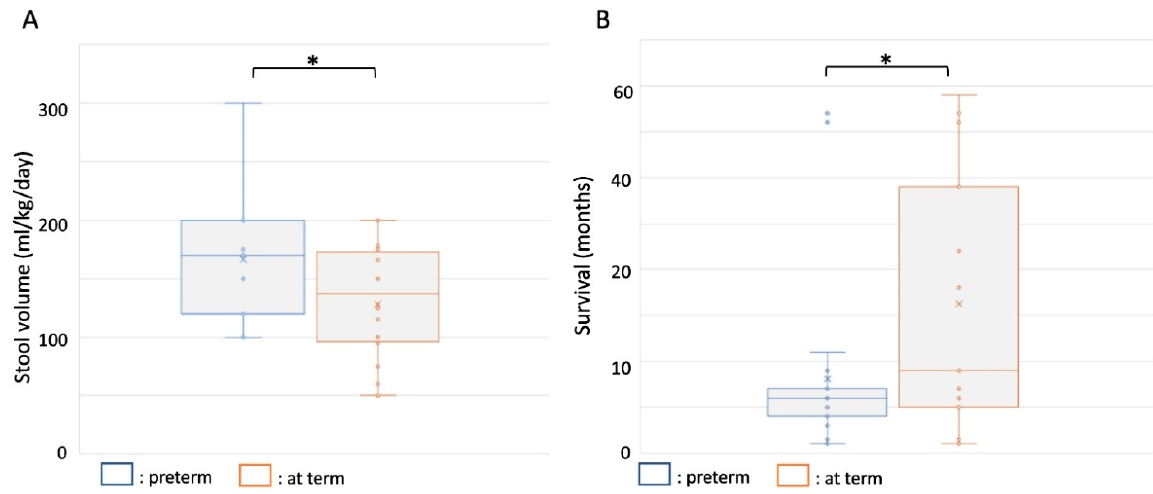
Figure 3. Stool volume and survival in MVID patients born preterm and at term. ( A ) Box-and-whisker plot showing average and mean stool volumes in MVID patients born preterm (blue) and at term (orange). ( B ) Box-and-whisker plot showing average and mean survival in MVID patients born preterm (blue) and at term (orange). *: p < 0.05 (for exact p values see text).